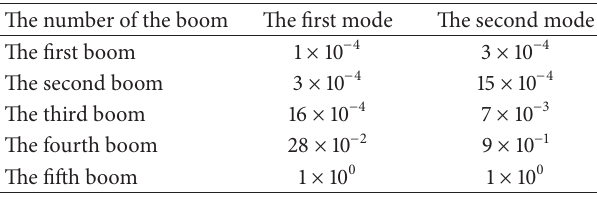
Table 2: The maximum modal displacement of each boom in the first two modes.